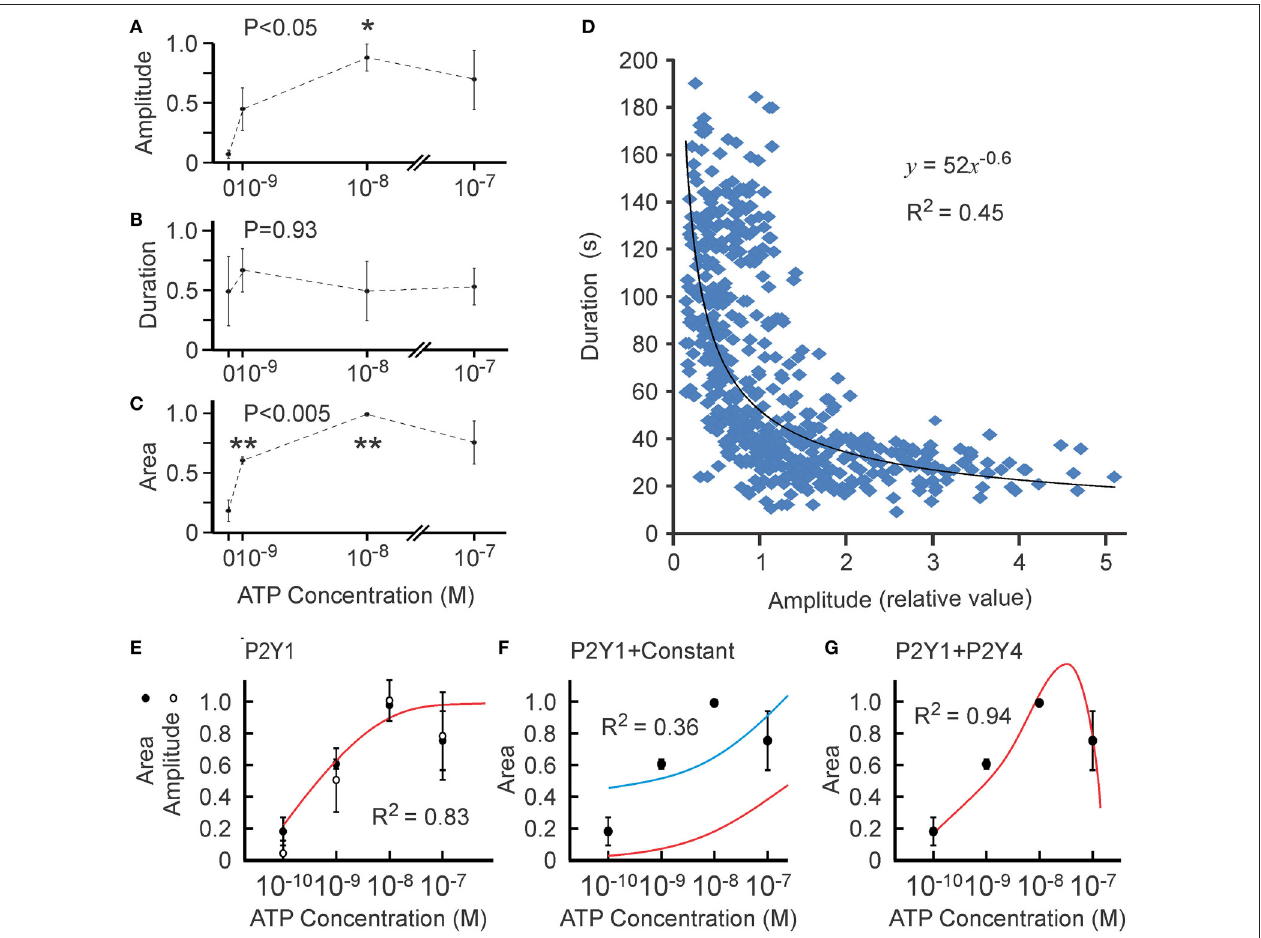
FIGURE 4 | Ca 2 + responses induced by low [ATP]. Changes in [Ca 2 + ] i induced by bath application of vehicle (0) or 10 − 9 –10 − 7 M ATP to MC3T3-E1 cells loaded with fluo-4 were analyzed. (A) [ATP] dependence of average peak amplitude. (B) [ATP] dependence of average response duration. (C) [ATP] dependence of average area under the curve. For (A–C) , data are means ± SEM, normalized to the maximal amplitude (A) , duration (B) or area under the curve (C) (maximal response = 1) within an experiment, n = 3 independent experiments, 17–35 cells per condition in each experiment. The differences were analyzed by ANOVA ( P -value given on the top of the graph) followed by Tukey post-test, * p < 0.05 ; ** p < 0.01 compared to vehicle (0). (D) The correlation between the amplitude and duration of Ca 2 + responses was examined in 563 individual cells exposed to 10 − 9 –10 − 7 M ATP. (E) Similar best fit for [ATP] dependence for amplitude (white circles) and area (black circles) of Ca 2 + responses. (F) The [ATP] dependence for the area was fit with the Hill equation of P2Y1 based on published data yielding no acceptable fit (red curve). The Hill equation of P2Y1 offset by a constant β is shown as the blue curve ( ky1 = 1 ± 2, β = 0.4 ± 0.6, R 2 = 0.36). (G) The [ATP] dependence for the area under Ca 2 + responses was fit with the linear combination of P2Y1 and P2Y4 functions ( ky1 = 7 ± 1, ky4 = − 25 ± 8, R 2 = 0.94